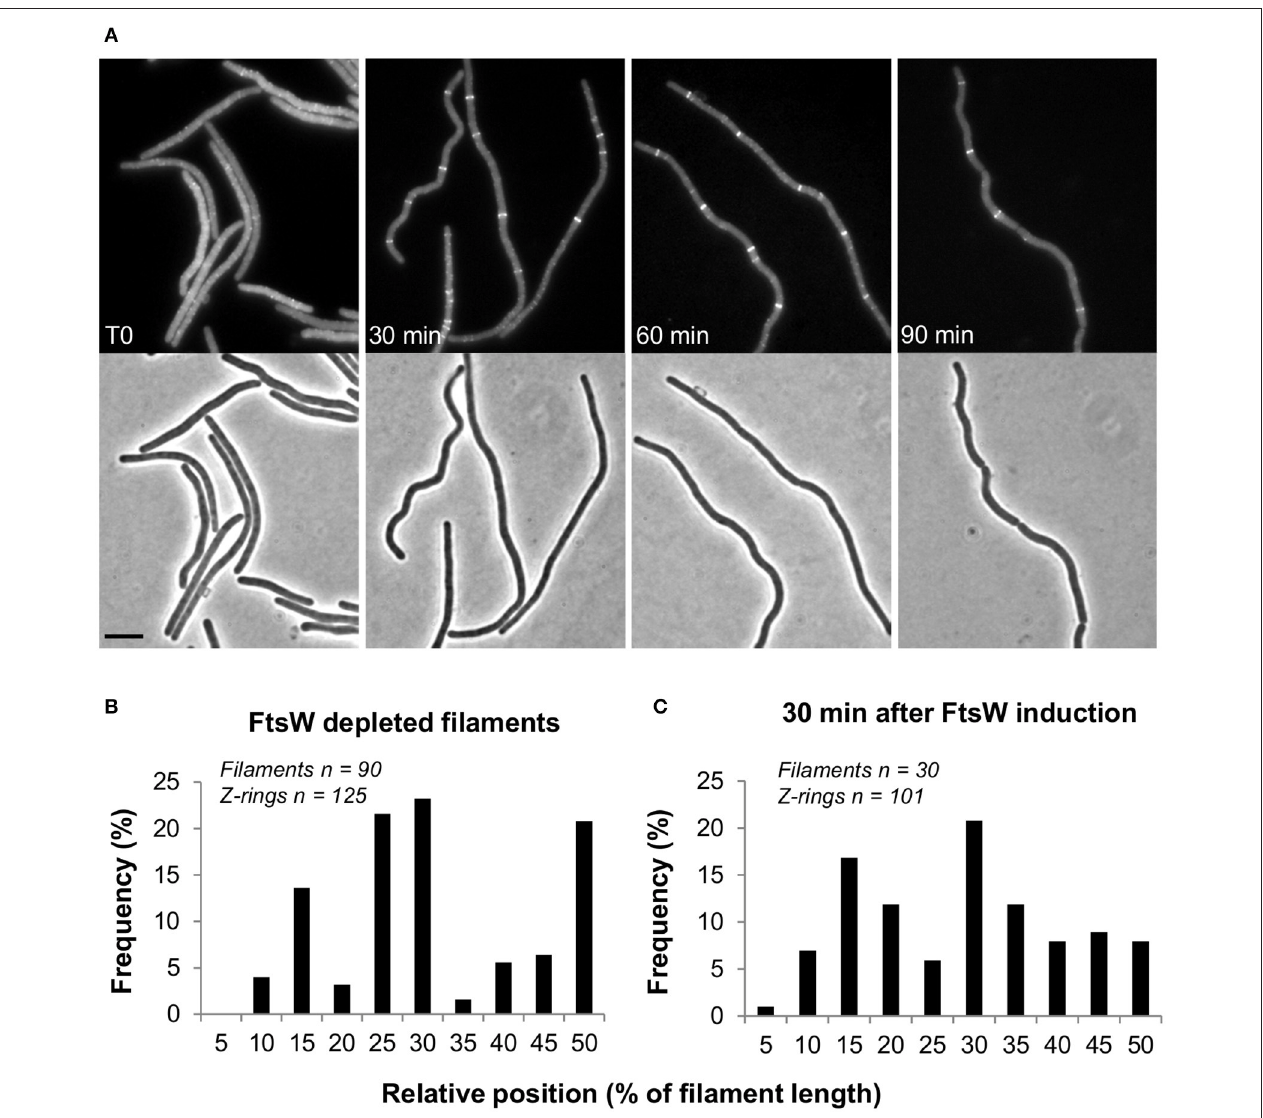
FIGURE 2 | Z-ring reassembly upon FtsW reinduction. Spores of strain PG80 ( P spac -ftsW; amyE :: P xyl -gfp-ftsZ ) were heat shocked as described and germinated at 37 ◦ C in the absence of IPTG. FtsW was reinduced by adding 1mM IPTG 5h after the beginning of germination. (A) Phase contrast and GFP images taken every 30 min after re-induction. Scale bar indicates 5 µ m. (B,C) Analysis of the relative positions of Z-rings in FtsW depleted filaments (B) and 30 min after the re-induction of ftsW expression (C) , determined using a combination of phase and fluorescence images. In both cases, the positions of the detected Z-rings have been expressed as the distance from the nearest cell pole and as a percentage of the cell’s total